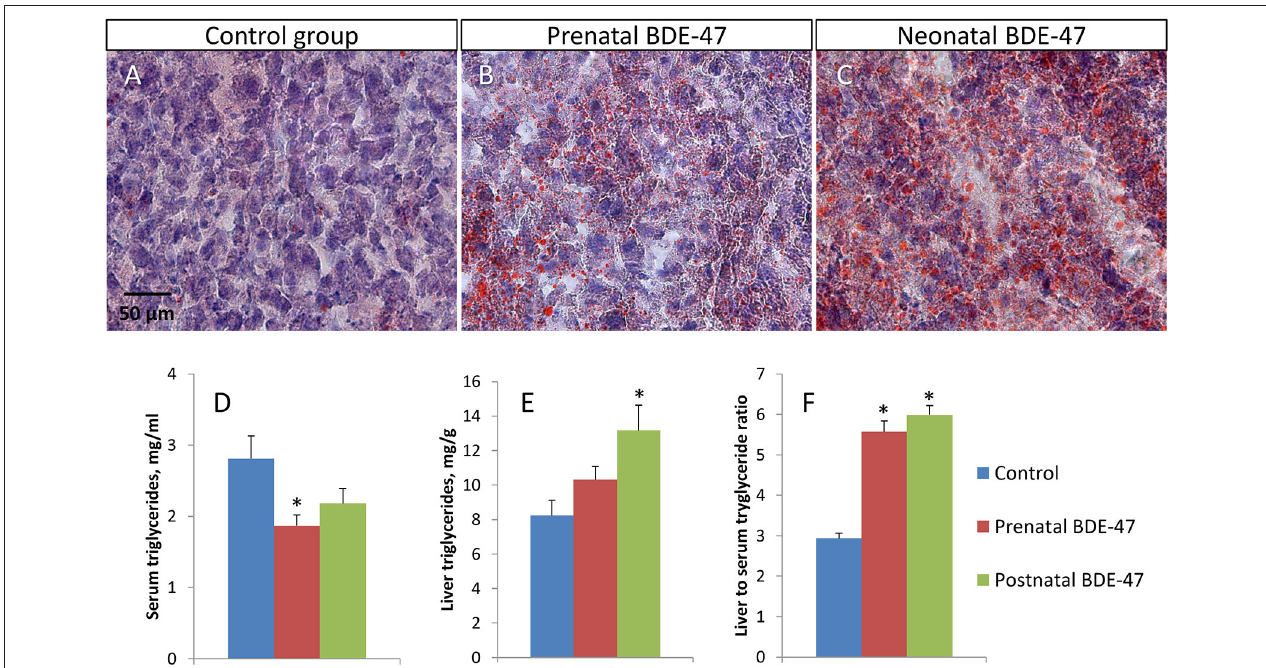
FIGURE 2 | Developmental exposure to BDE-47 results in altered triglyceride concentrations in hepatocytes and blood of 10 months old mice. (A–C) –representative liver tissue sections stained with Oil Red O and Harris’ hematoxylin ( × 400): (A) –control group, (B) –prenatal exposure group, (C) –neonatal exposure group. Lipid droplets are stained in orange. (D,E) –triglyceride concentrations in blood and liver, respectively. (F) –liver to serum triglyceride ratio. All data are Mean ± SE, n = 10/exposure group, ANOVA followed by Dunnett’s test, * p < 0.05 when compared with control